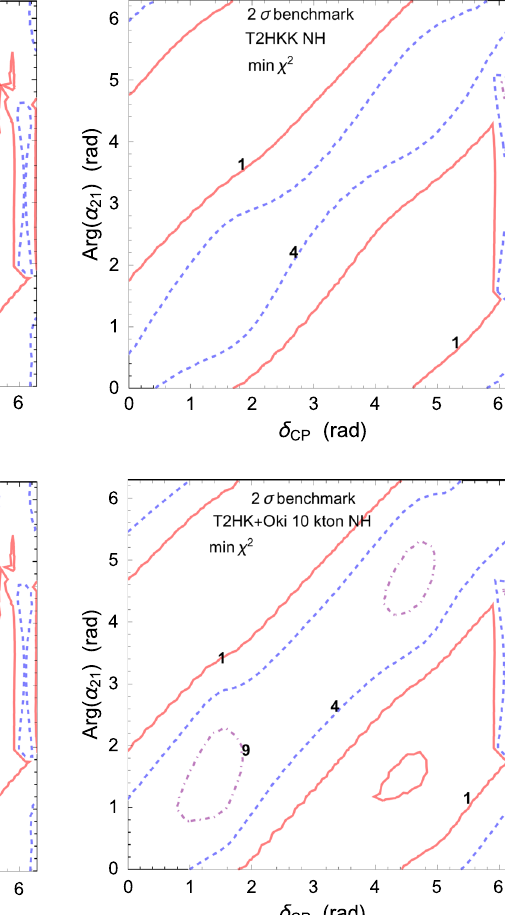
ative study, we show in the lower-left a subplot for a plan of the T2HK plus a 10 kton water Cerenkov detector at Kamioka. min χ 2 = 1 , 4 , 9 on the red solid, blue dashed, and purple dot-dashed contours, respec- tively